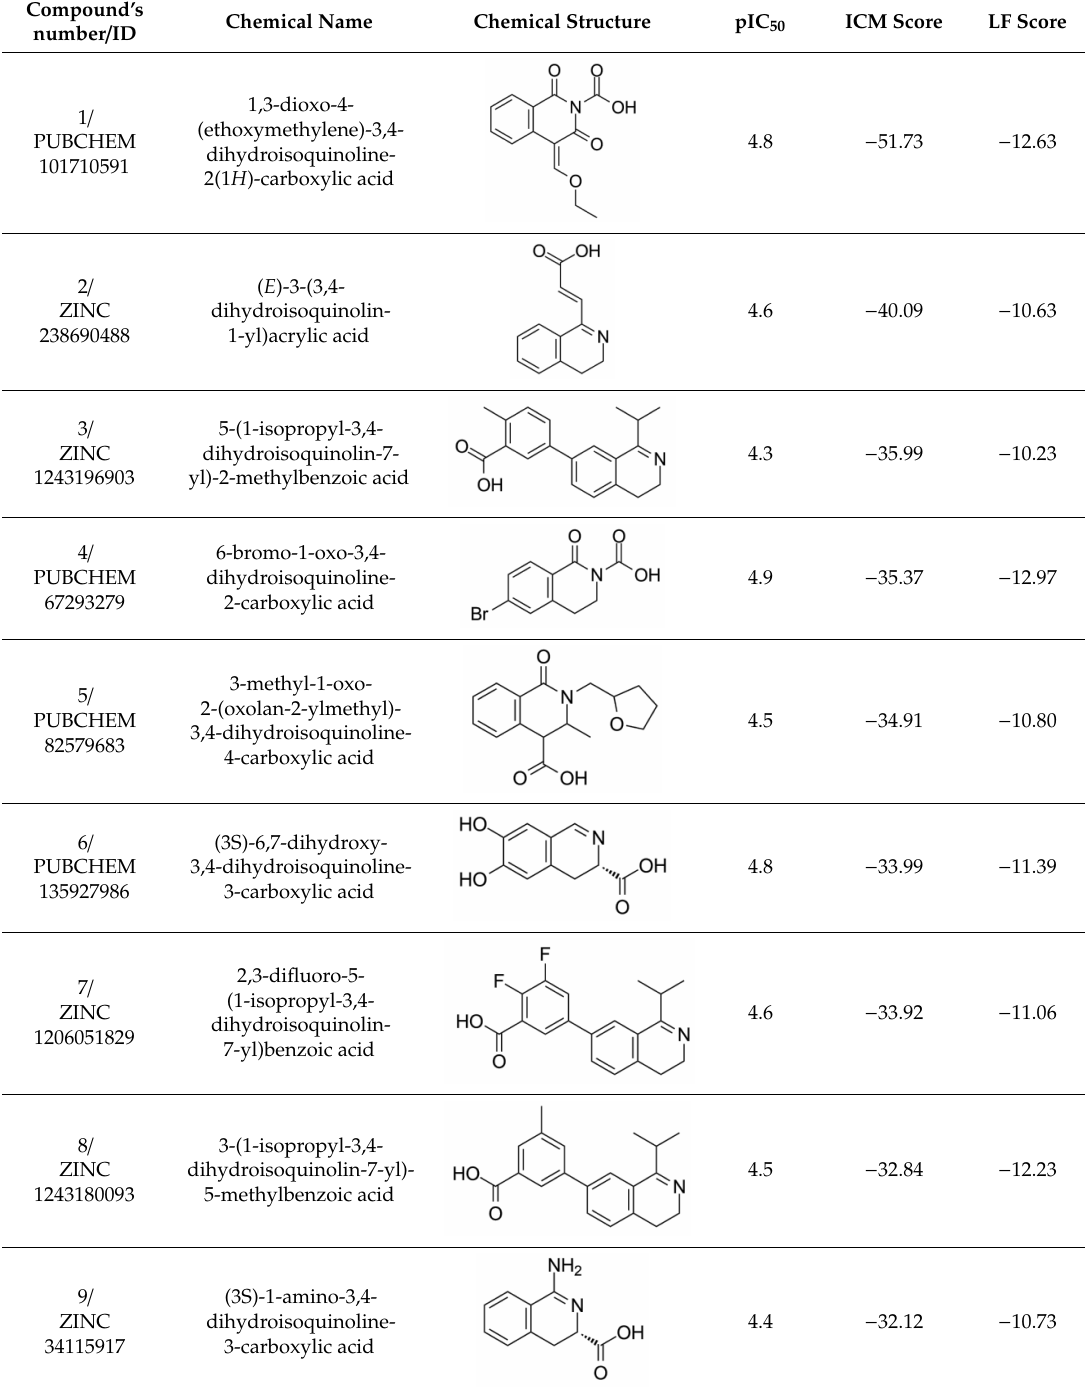
Table 1. Chemical structures and calculated pIC 50 values of the selected